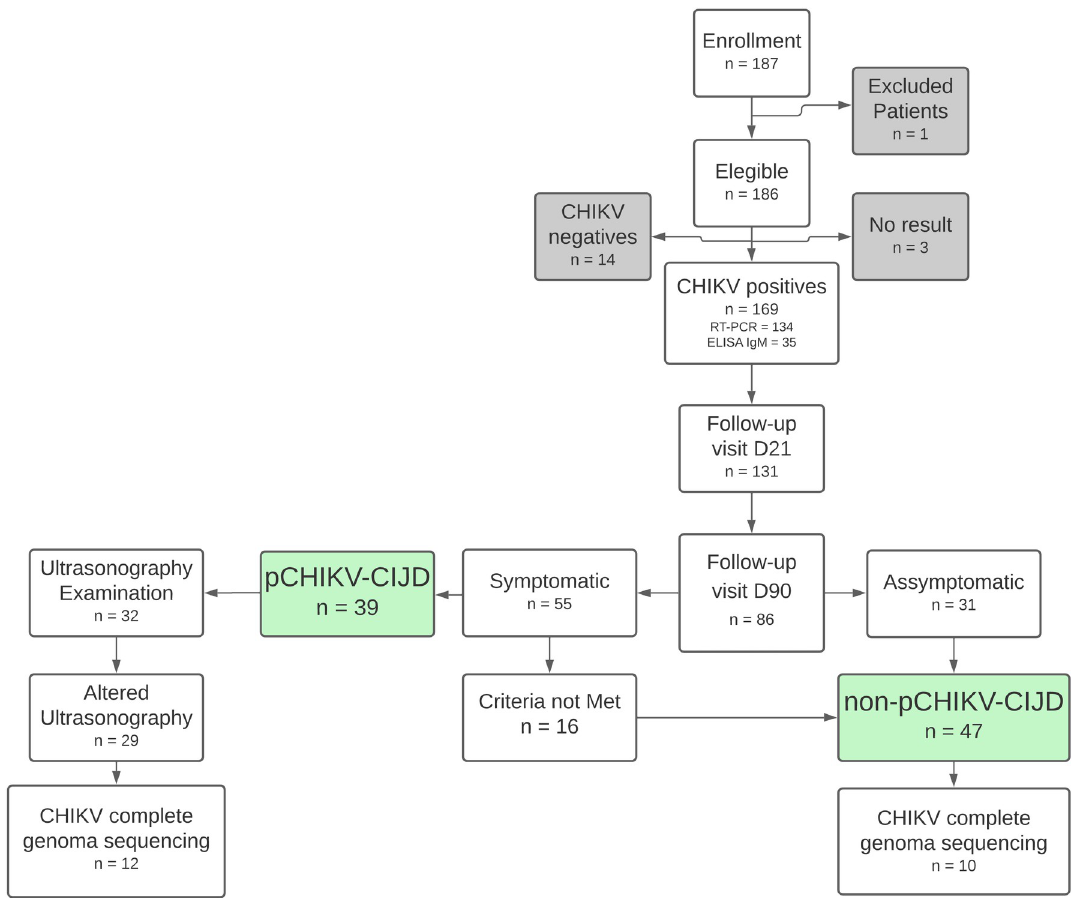
Fig 1. Flowchart showing the progress of the CHIKF cohort. Gray frames represent patients who were excluded from the analysis. Green frames represent the two study groups analyzed. n = number of patients; D21 = Follow–up visit 21 days after inclusion; D90 = Follow–up visit 90 days after inclusion; pCHIKV–CIJD = post–Chikungunya chronic inflammatory joint disease; non– pCHIKV–CIJD = patients who did not met criteria of